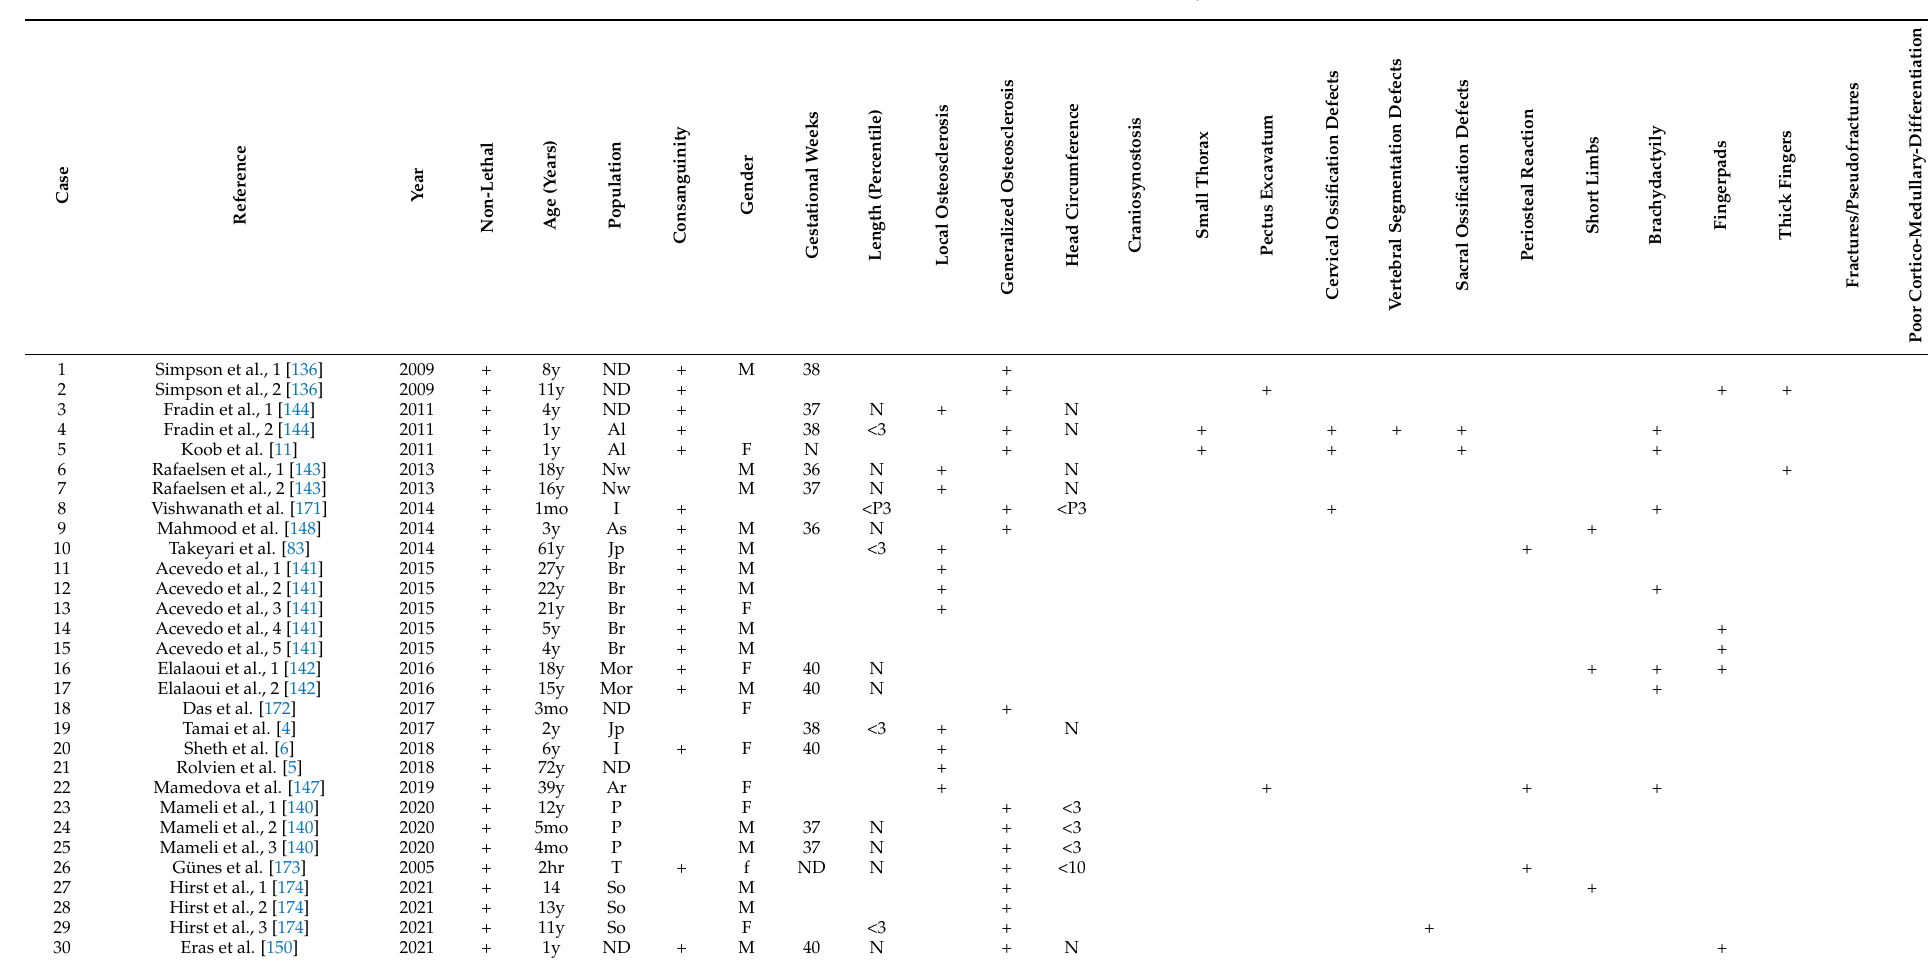
Table 6. Skeletal abnormalities in non-lethal Raine